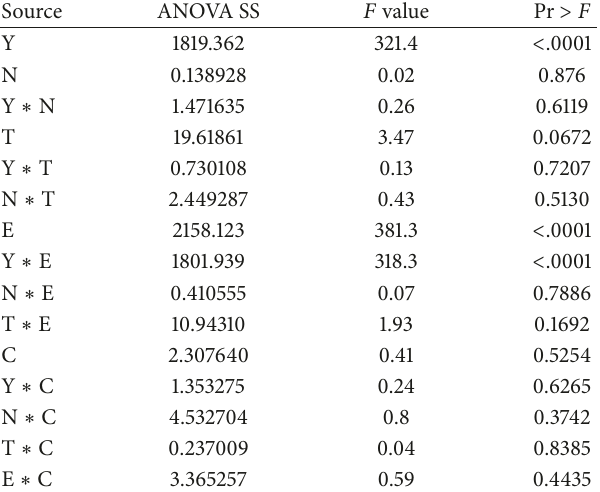
Table 2: Significance of treatments on percent crude protein at 48 hours of incubation. Y: yeast species; N: nitrogen supplement; T: thermal treatment; E: enzyme; C: coculture. Significant